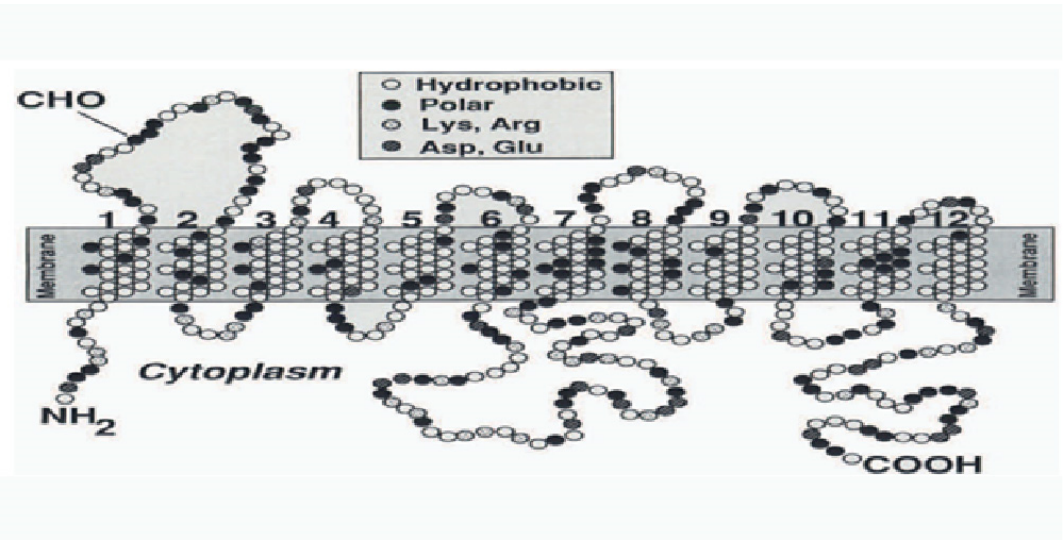
Figure 3. Schematic membrane topology of facilitative glucose transporters ((Małgorzata et al., 2005) [73].